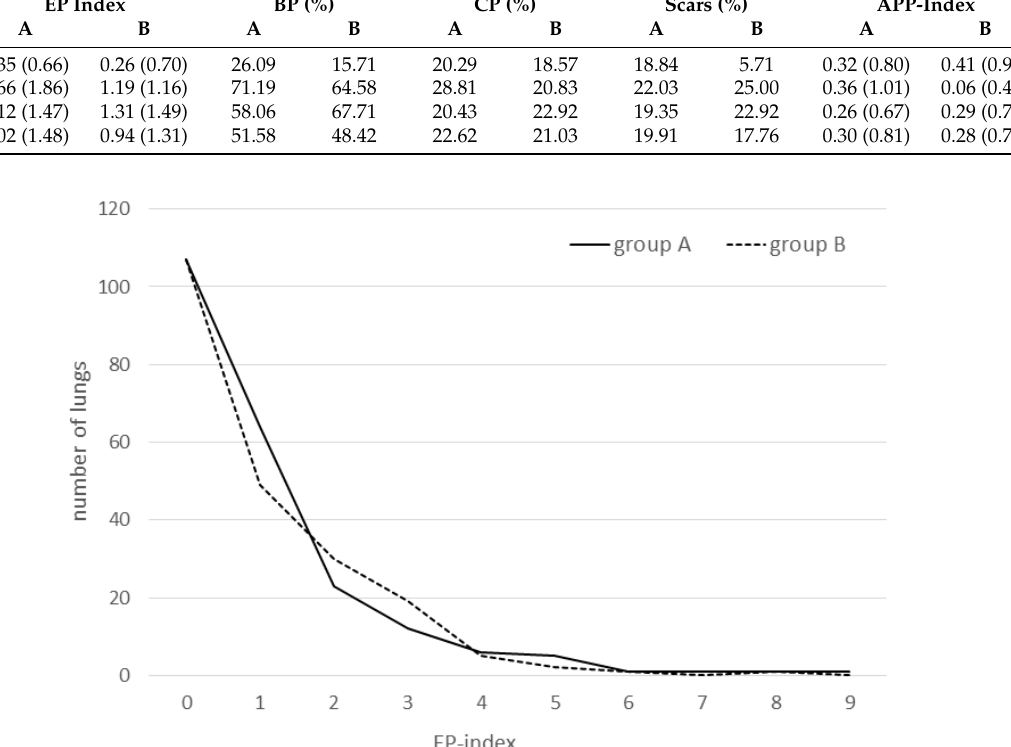
Table 2. Lung score data at slaughter for animals of group A (IM vaccine) and group B (ID vaccine). Index values are given as means and SD. EP: enzootic pneumonia, BP: bronchopneumonia, CP: cra- nial pleurisy, APP: A.pp.- pleuropneumonia.